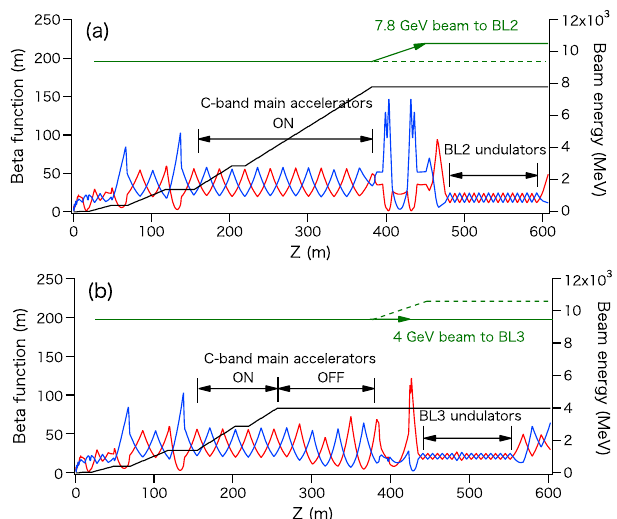
FIG. 4. Beam envelopes calculated for 7.8 and 4 GeV beams with the focusing lattice of SACLA. The lattice is initially optimized for the 7.8 GeV beam of BL2 (a), then the envelope distortion is calculated for the 4 GeV beam of BL3 with the same quadrupole fields at the C-band main accelerator (b). The red and blue lines are horizontal and vertical beta functions, and the black lines are the beam energy along the accelerator. The locations of the C-band main accelerator and the undu- lators are indicated in the figures. Note that there is a 16 m- long drift space in the C-band main accelerator around Z ¼ 200 m